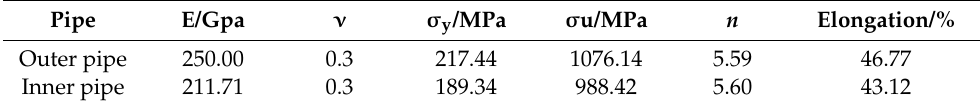
Table 2. Material parameters of the tested specimens.